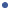
Peptides can be used to covalently biotinylate polyP.A) PolyP1000 was reacted with EDAC and a biotinylated peptide, either SAAAK(biotin) (●), or biotin-AAAS (▼), and then purified. Degree of polyP biotinylation was assessed by the microplate-based thrombin-binding assay. B) PolyP1000 was reacted with EDAC in the presence of the peptide, KAKAK (●) or in the absence of peptide (▲). Following purification, polyP preparations were incubated with sulfo-NHS-LC-biotin and repurified. Extent of biotinylation was assessed by the thrombin-binding assay.